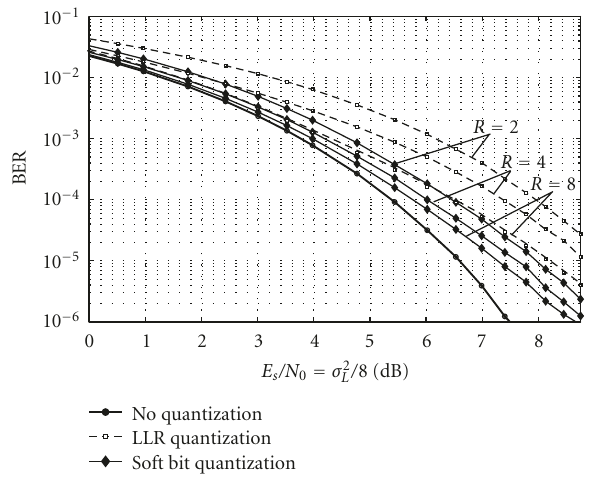
Figure 6: BER after soft combining of L -values for quantized information exchange with optimized levels in either the soft-bit or LLR domain.